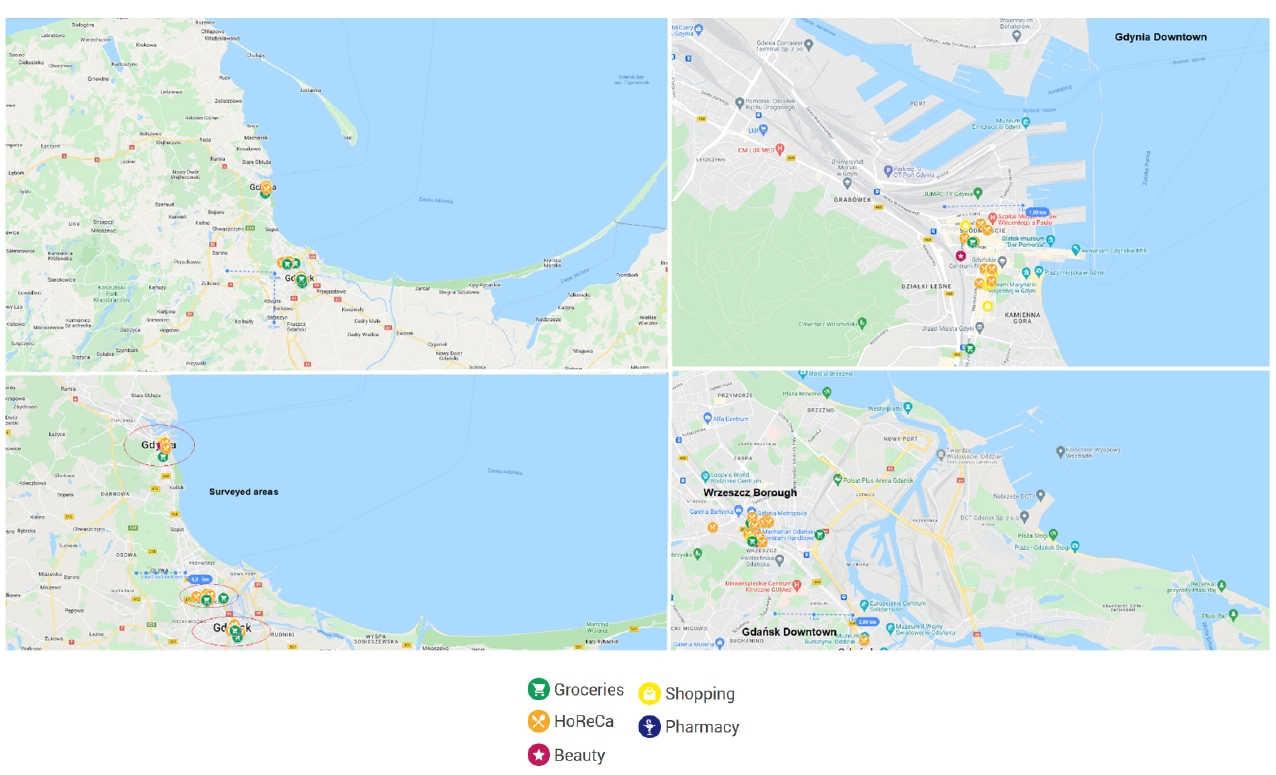
Figure 1. Location of the surveyed areas in the agglomeration of Tri-City, Poland. Table 3. Business profile of the surveyed premises. The Number of the Surveyed Premises Surveyed Premise Profile Hotels, Restaurants, Cafes